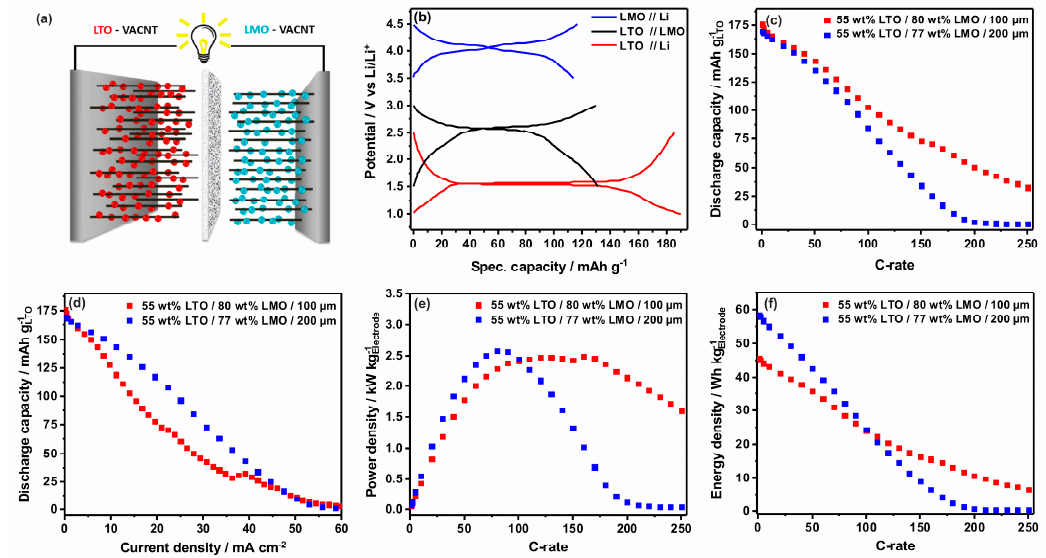
Figure 7. Electrochemical characterization of LTO–VACNT//LMO–VACNT full cells. ( a ) Schematics of as-fabricated VACNT-based lithium ion batteries (LIB). ( b ) Voltage profiles of LMO and LTO half-cells and corresponding LTO/LMO full cell at 1C. ( c ) Galvanostatic rate test of 100 µm and 200 µm VACNT-based LTO/LMO full cells up to 250C. ( d ) Capacity of full cells plotted against the applied areal current density. ( e ) Power density of full cell nanoarrays at discharging. ( f ) Energy density of full cell nanoarrays at discharging.